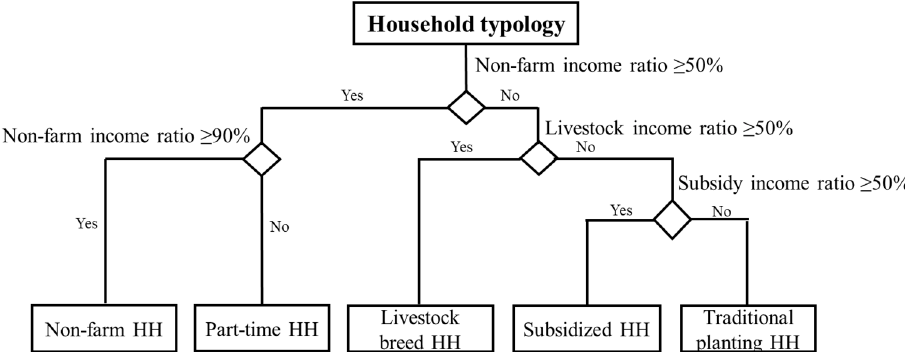
8 of 16 Table 4. Distribution of household clusters derived from the Two-Step cluster analysis. Percentage of Households